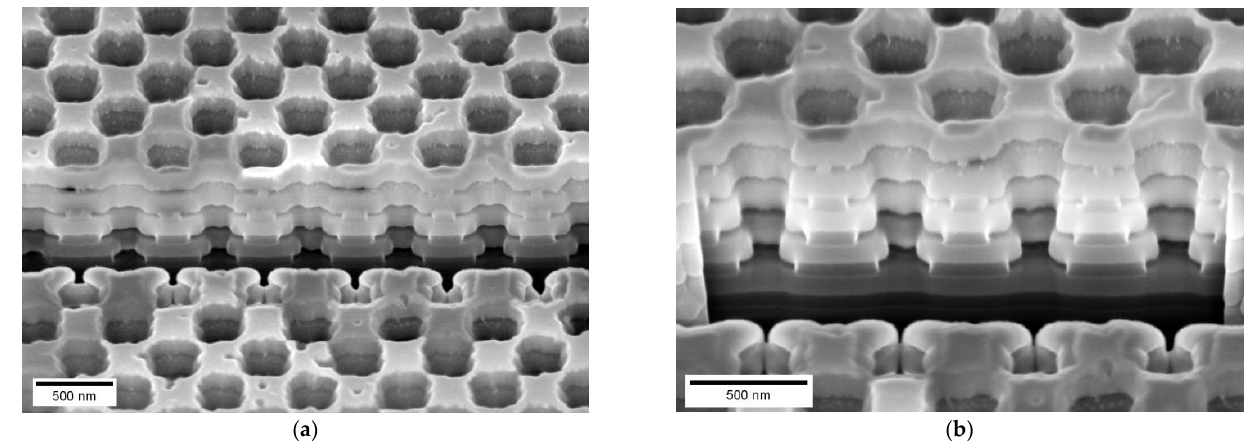
Figure 6. A multilevel underetched structure with a gold hard mask was defined by a NIL imprinted stamp. A 2D checkerboard structure consisting of 300 × 300 nm 2 squares was transferred into a metal layer acting as etch hardmask. The checkerboard pattern was transferred into the material by RIE etching. ( a ) Overview; ( b ) close-up.